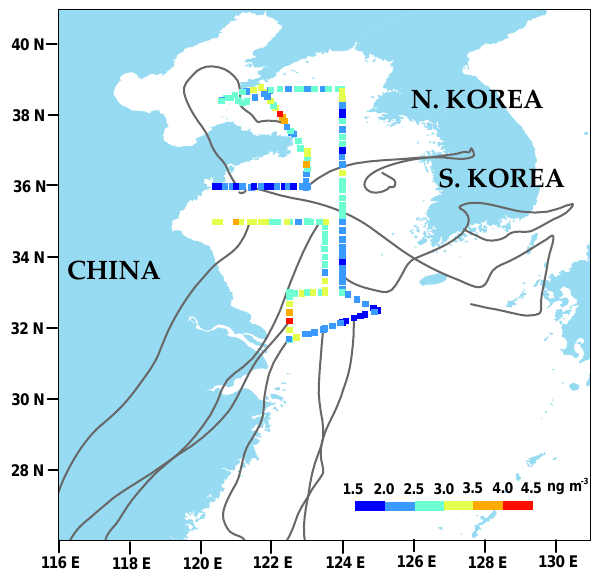
Fig. 3. Atmospheric GEM distribution over the Yellow Sea and the typical back-trajectories of air masses during the cruise in July 2010. See text for more information on the calculation of the back-trajectory. 0° E).